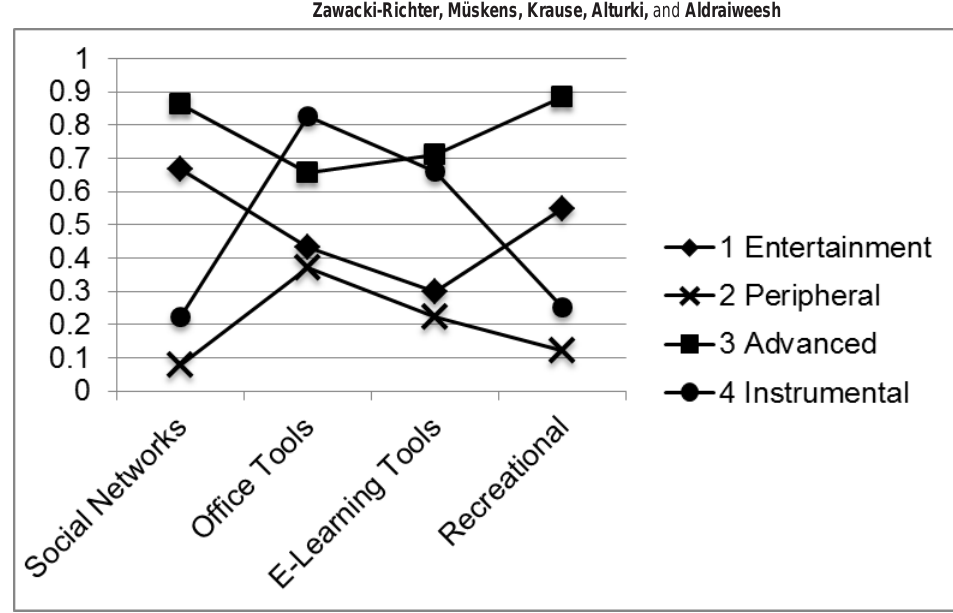
Figure 2. Profiles of the class-specific means.